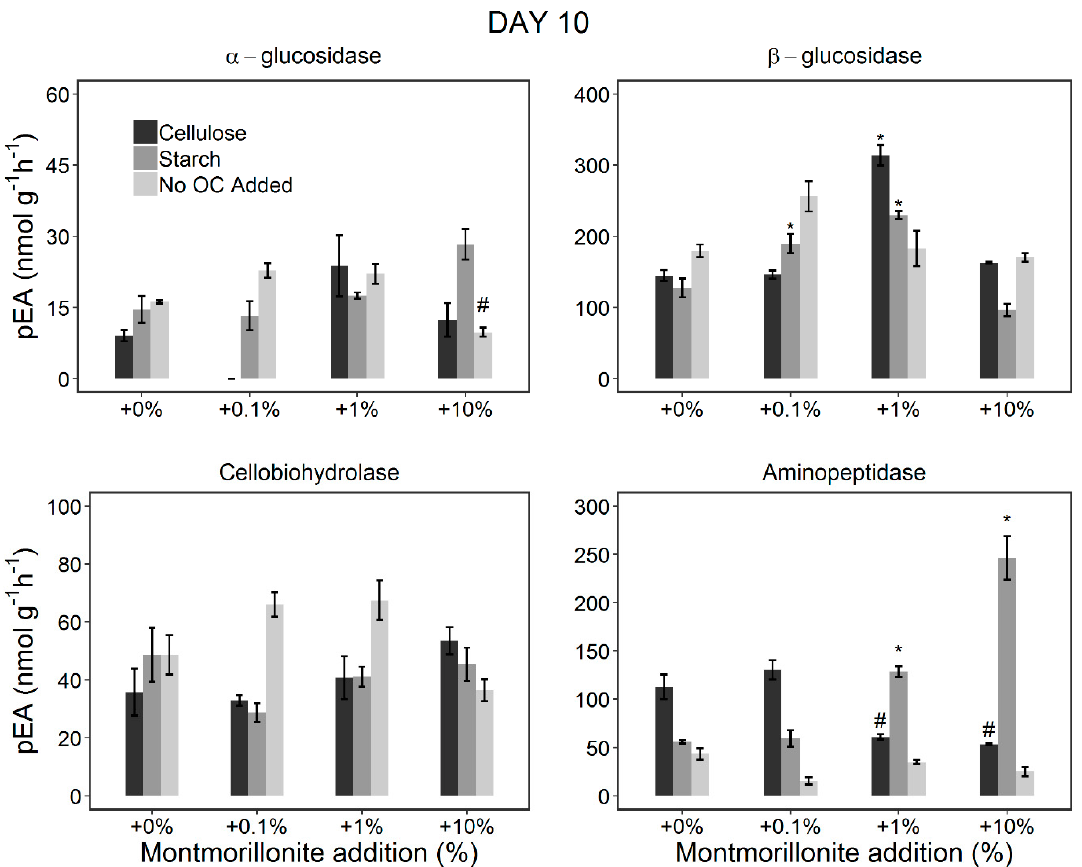
Figure 4. Thepotentialenzymeactivities(pEA)of α -glucosidase(AG), β -glucosidase(BG)cellobiohydrolase Figure 4. The potential enzyme activities (pEA) of α -glucosidase (AG), β -glucosidase (BG) (CB)andaminopeptidase(AM)measuredinthesoilmanipulatedbyincreasingmontmorilloniteaddition cellobiohydrolase (CB) and aminopeptidase (AM) measured in the soil manipulated by increasing without added OC or with the addition of OC (starch or cellulose) at day 10 of the incubation. Error bars montmorillonite addition without added OC or with the addition of OC (starch or cellulose) at day represent standard error of means (n = 3). Bars with statistical significant di ff erence ( p < 0.05) from the 10 of the incubation. Error bars represent standard error of means (n = 3). Bars with statistical control ( + 0%) are marked with * (increase in pEA) and # (decrease in pEA). Mean comparison was significant difference ( p < 0.05) from the control (+0%) are marked with * (increase in pEA) and # done among treatments in the same group (cellulose or (decrease in pEA). Mean comparison was done among treatments in the same group (cellulose or starch).